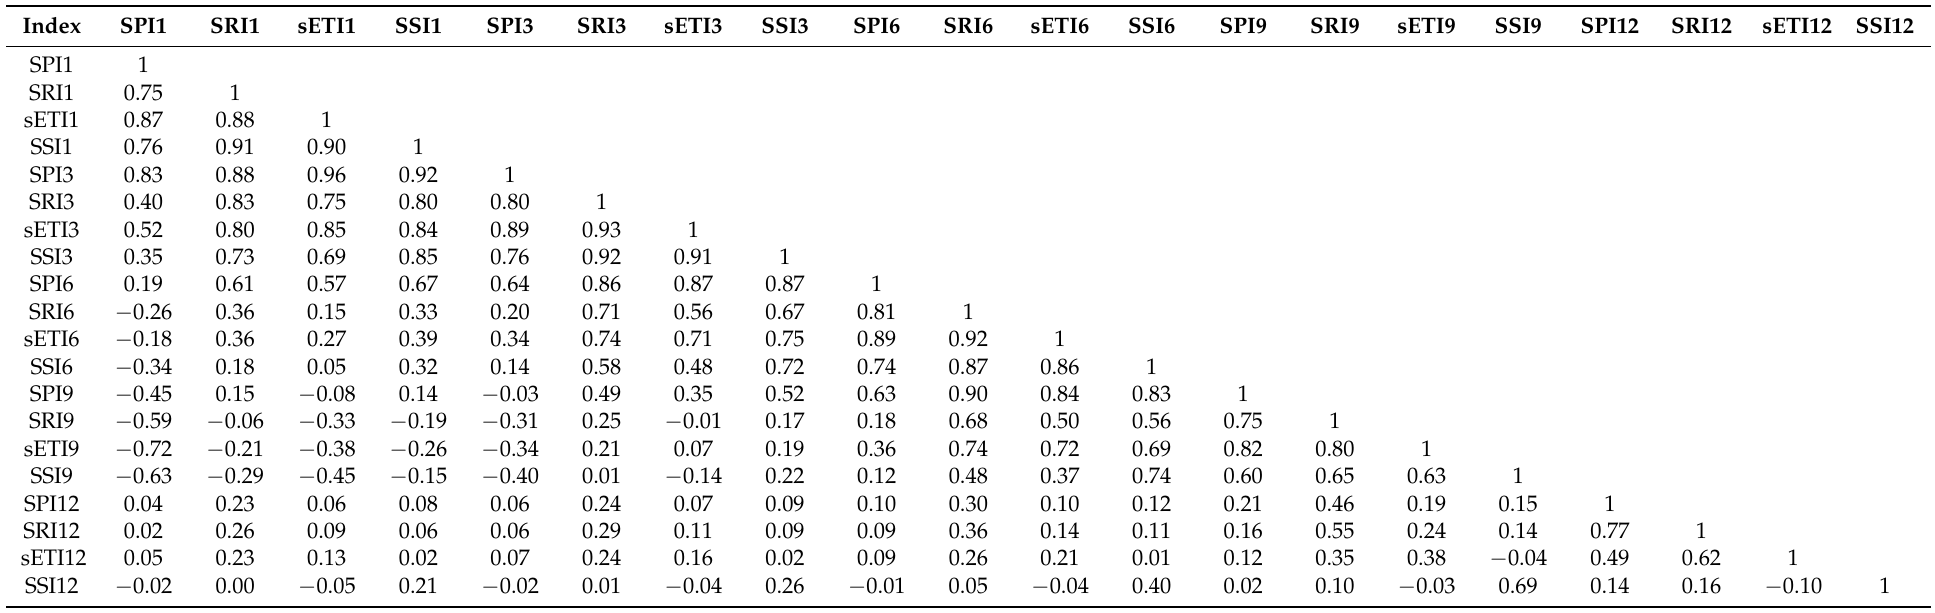
Table 2. The Pearson’s correlation coefficient (r) matrix at different timescales of the drought